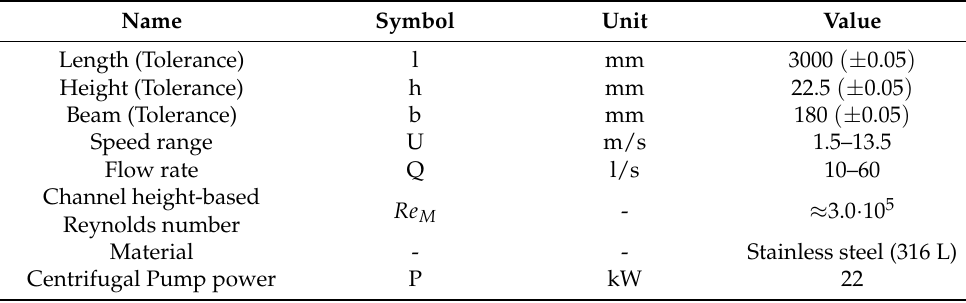
Table 1. Main particulars of the FTFC upper